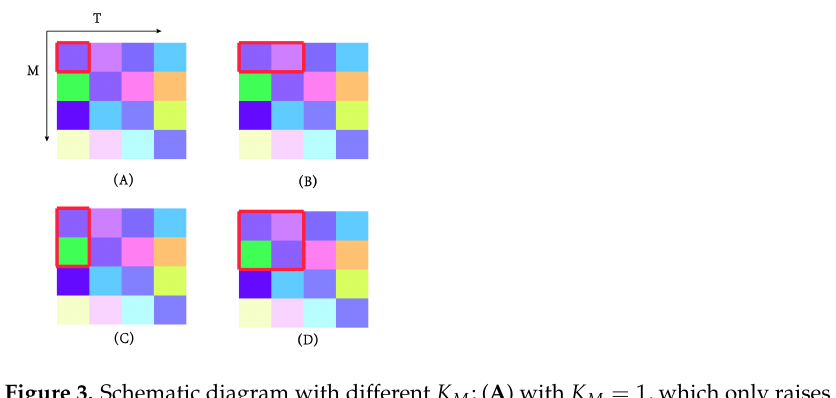
Figure 3. Schematic diagram with different K M ; ( A ) with K M = 1, which only raises the dimensions of the bone points on each frame; ( B – D ) with different K M settings, which model the relationships of the bone points in local areas of spatial and temporal